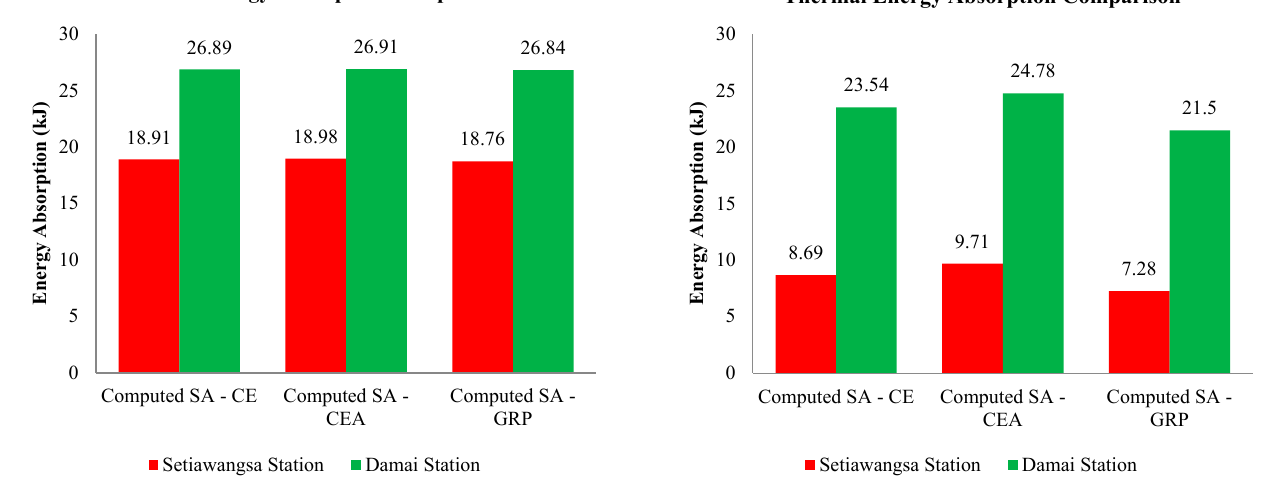
Figure 14. Comparison of the arrester thermal energy absorption between the computed bracket material cases for both